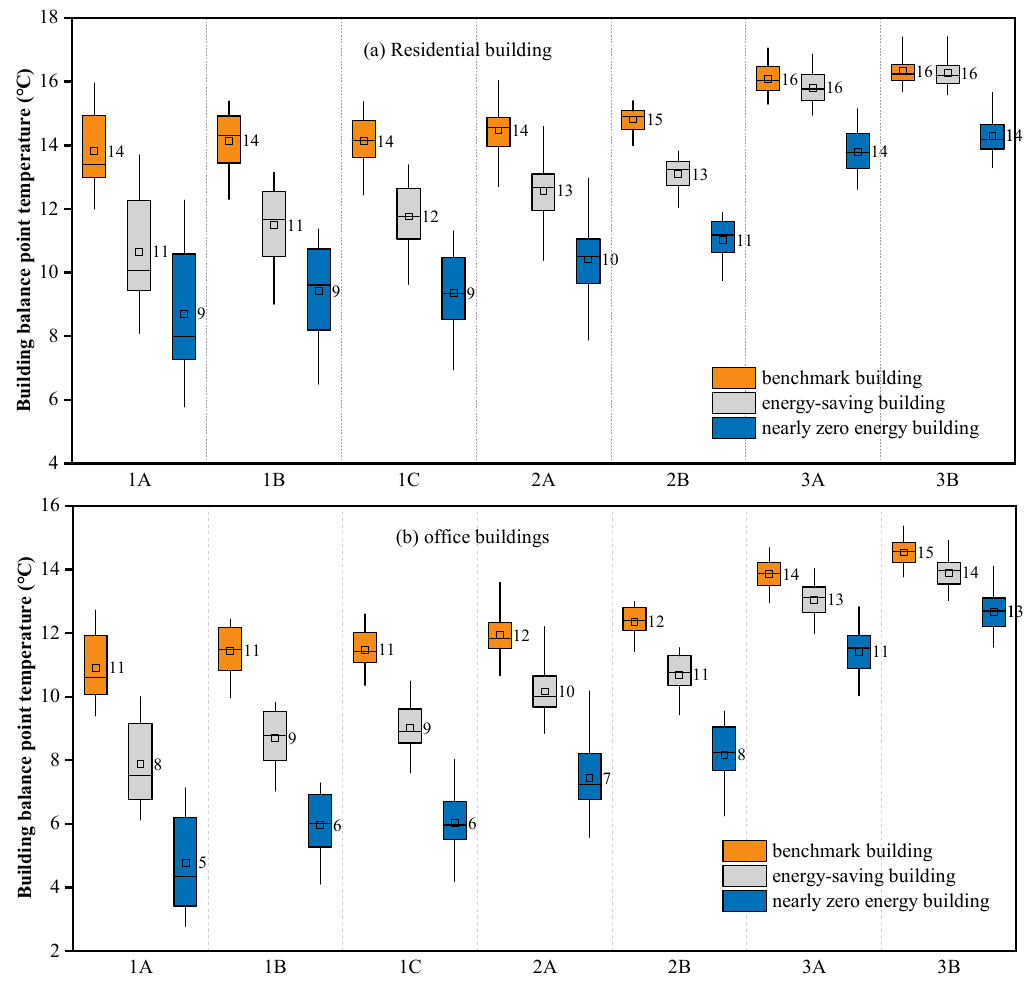
Figure 11. Building balance point temperatures in different climate zones ( a ) residential building; ( b ) office building.